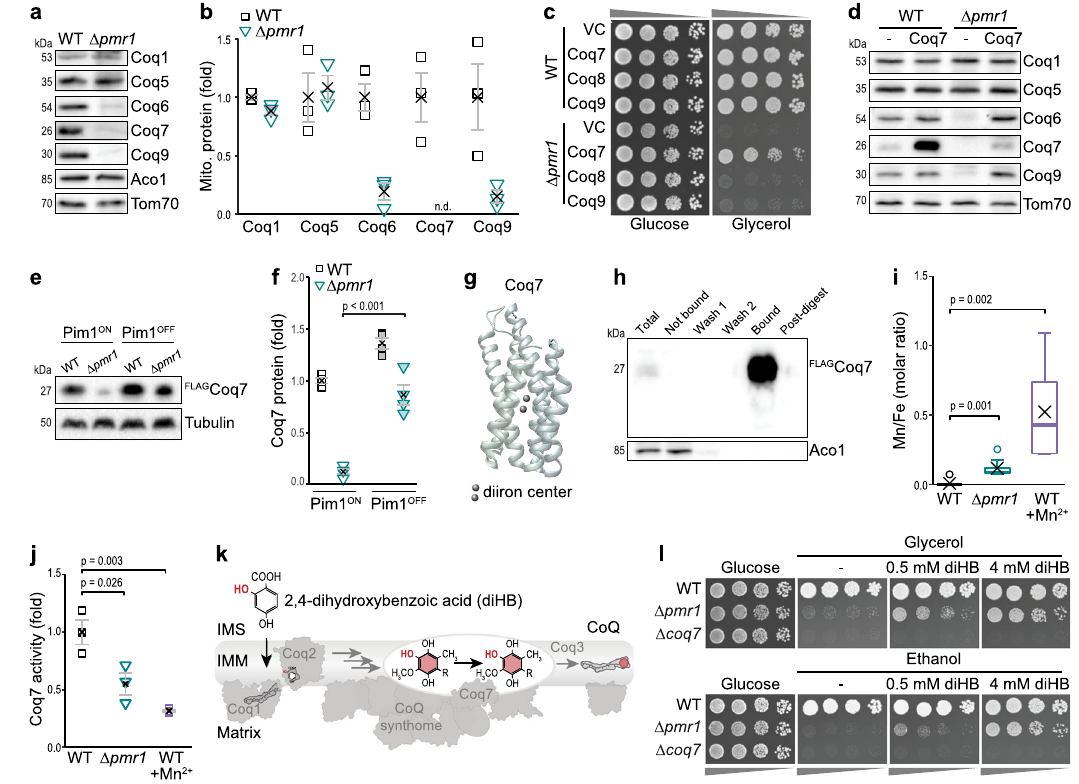
FLAG Coq7 puri fi ed with anti-FLAG af fi nity gel from mitochondria isolated from WT cells overexpressing Coq7 and co-expressing Coq9 to stabilize Coq7 and increase protein yield. i TXRF-based determination of the Mn/Fe ratio in Coq7 protein puri fi ed from mitochondria isolated from WT and Δ pmr1 cells and from WT cells exposed to 5mM MnCl 2 for 24h. All cells overexpressed FLAG Coq7 and Coq9. Box plot shows mean (x), median (line), fi rst/third quartile (lower/upper bound), minimum/maximum within 1.5-fold IQR (lower/upper whisker), and out- liers outside 1.5-fold IQR (circle/o), n =9. j In vitro quanti fi cation of hydroxylase activity of Coq7 puri fi ed from mitochondria from WT and Δ pmr1 cells and from WT cells exposed to 5mM MnCl 2 for 24h. All cells overexpressed FLAG Coq7 and Coq9asin( h , i ).Means±SEM, n =3. k Schematicrepresenting thebypassofCoq7- catalyzed hydroxylation by 2,4-dihydroxybenzoic acid (diHB). l Spotting of WT, Δ pmr1 ,and Δ coq7 cellsonglucose,glycerol,andethanolplatessupplementedwith diHB as indicated. Details for statistical analysis (Supplementary Table 9) and source data are